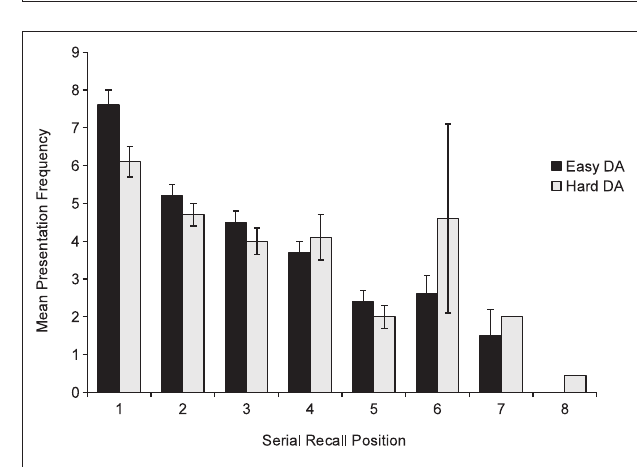
FiGure 6 | Mean presentation frequency of recalled items as a function of serial recall position for experiment